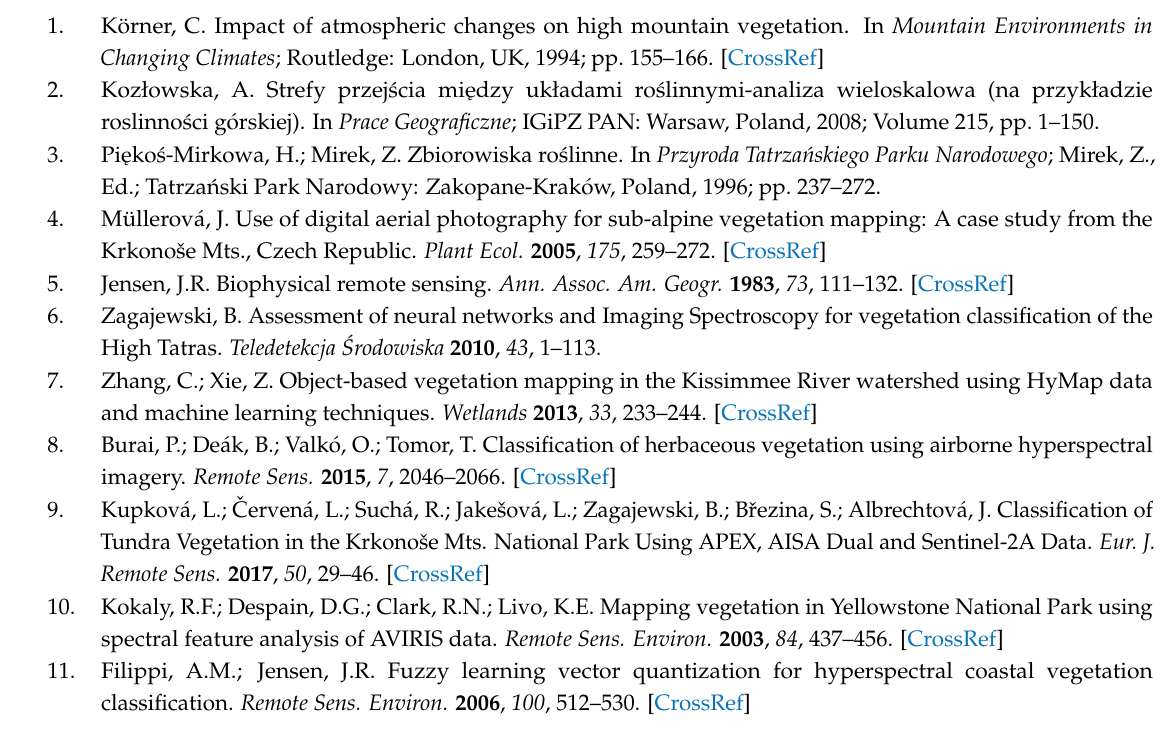
Figure S1: Increased accuracy of classification caused by the increase in the number of training pixels, Table S1: Error matrix for the best iteration of 40 PCA bands, in